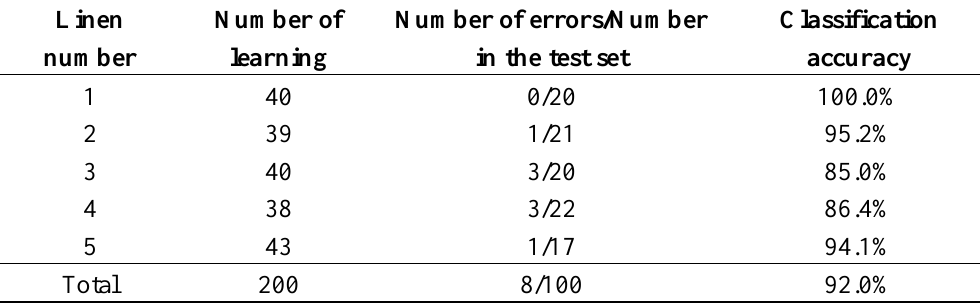
Table 1. The results of classification with